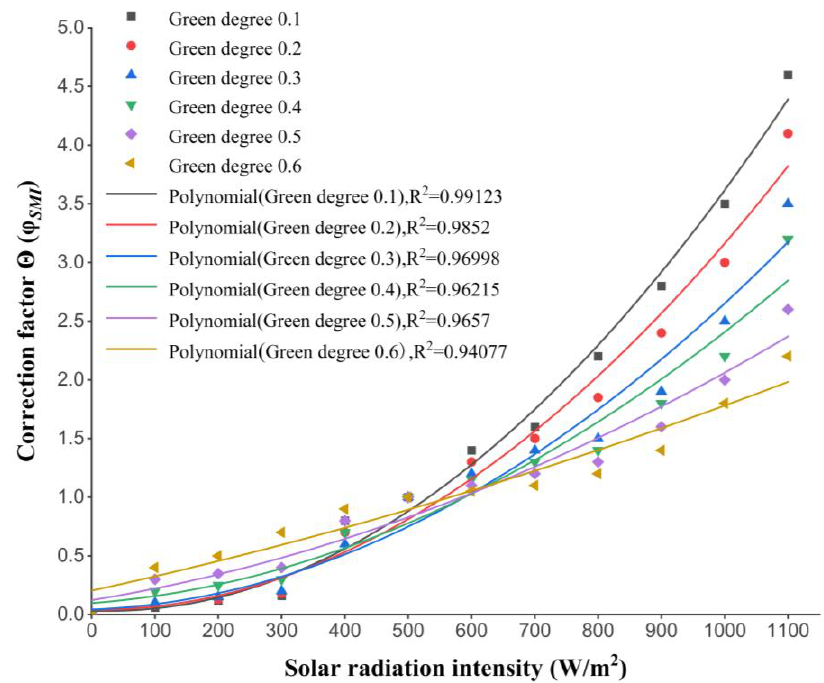
Figure 8. The influence of solar radiation intensity on the cooling effects. (Compared with the cooling range of reference standard (500 W/m 2